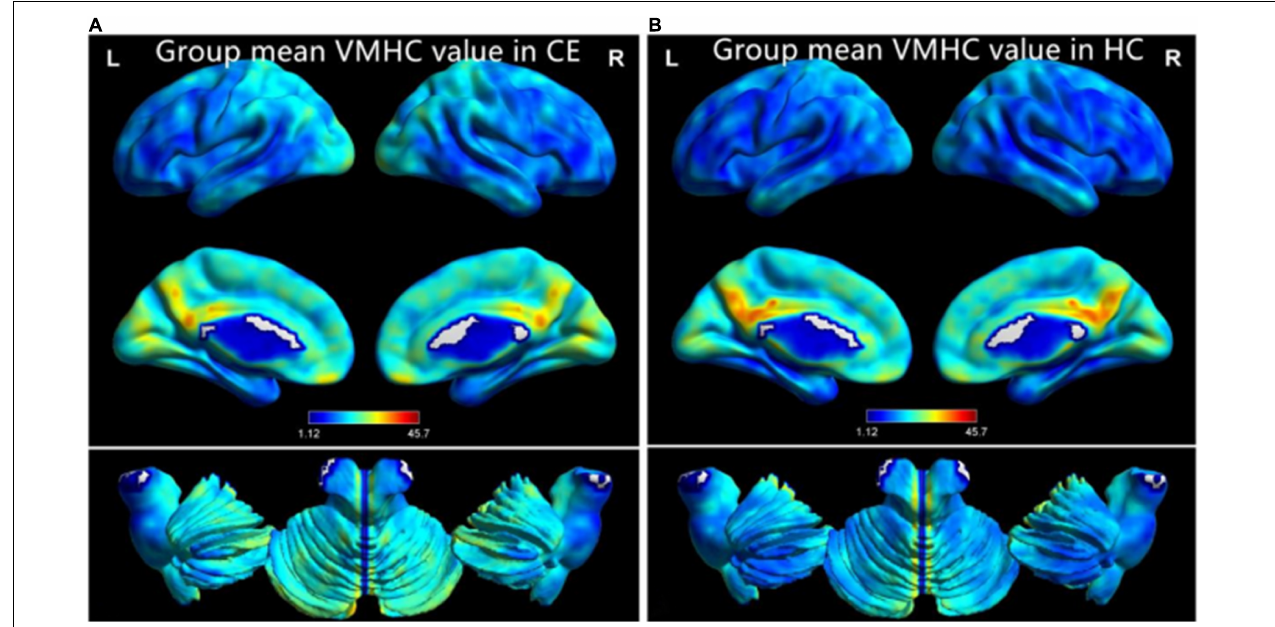
FIGURE 1 | One-sample t -test results of VMHC maps within comitant extropia (CE) group (A) and HC group (B) . Abbreviations: CE, comitant exotropia; HC, health control; and VMHC, voxel-mirrored homotopic connectivity. TABLE 2 | Different voxel-mirrored homotopic connectivity (VMHC) values between two groups. Condition